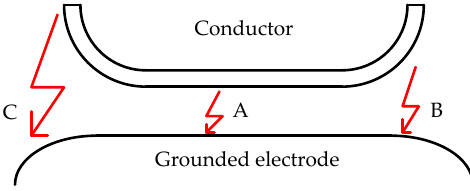
Figure 8. Curvature of conductors used in comparative tests in [2].